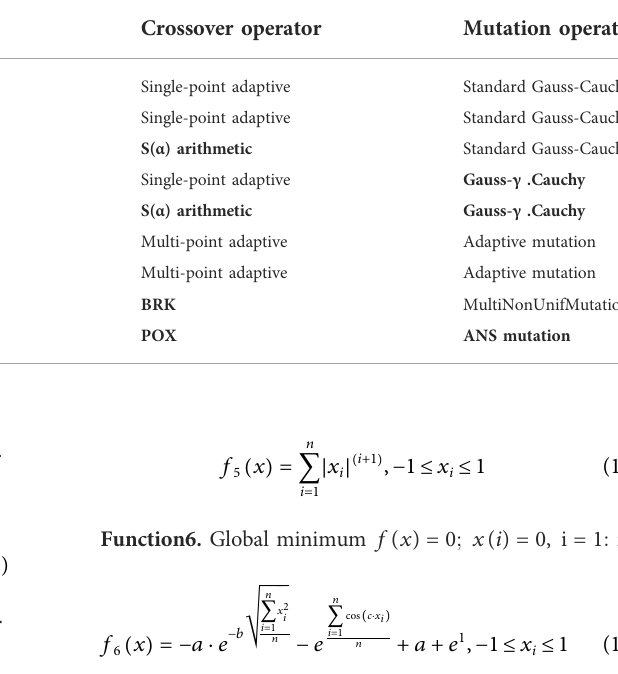
TABLE 2 The genetic operators contained in the nine designed